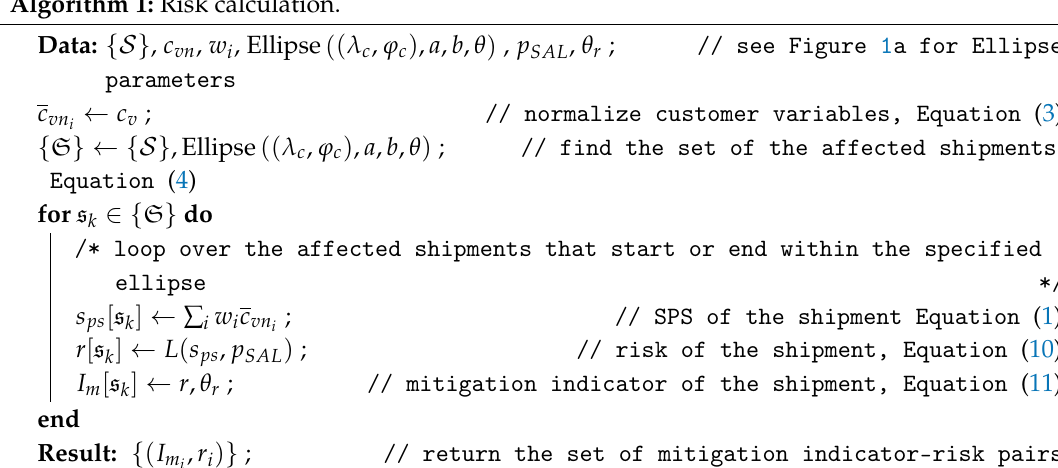
Algorithm 1: Risk